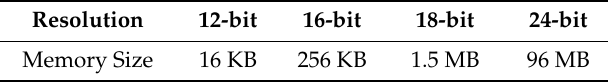
Table 2. Demand of memory size.